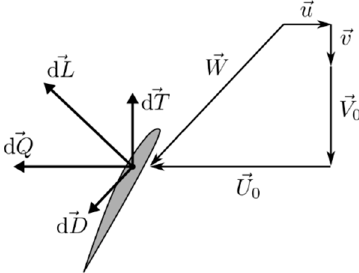
Figure A1. Flowfield and forces on the propeller blade.